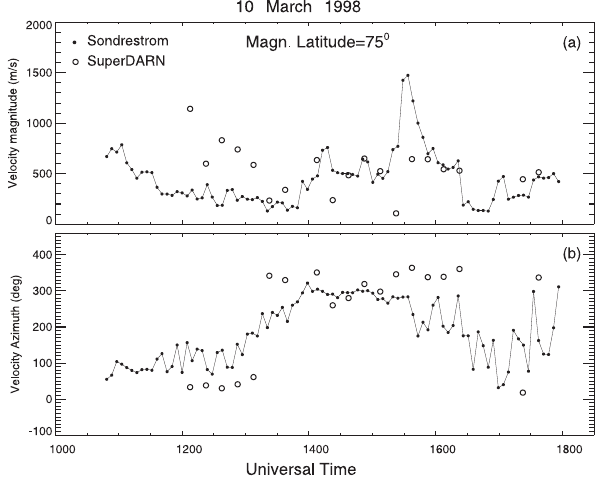
Fig. 3. The same as in Fig. 2 but for the 3 June 1998 event at latitudes of 75.75 ◦ –76.25 ◦